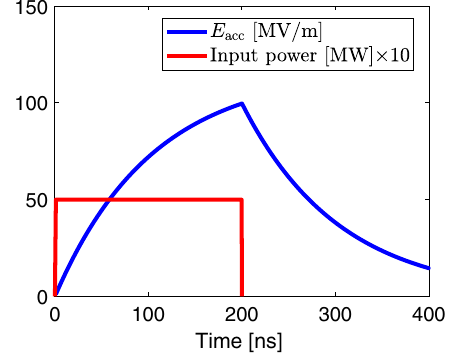
FIG. 12. Pulse waveform of normal event at flat top pulse width excited in of 250 ns. (a) Directional coupler signals. Red curve is the acc incident microwave signal and blue curve is the reflected microwave signal. (b) Faraday cup signals. The red curve is the signal of the power feed end and the blue curve is the signal of the power cut end.